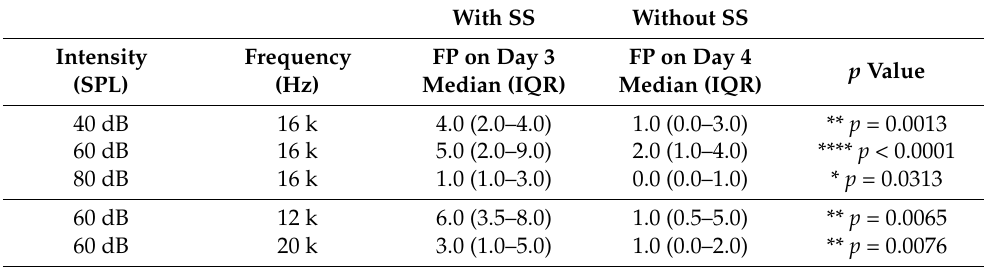
Table 1. Comparison of FP scores on days 3 and 4.